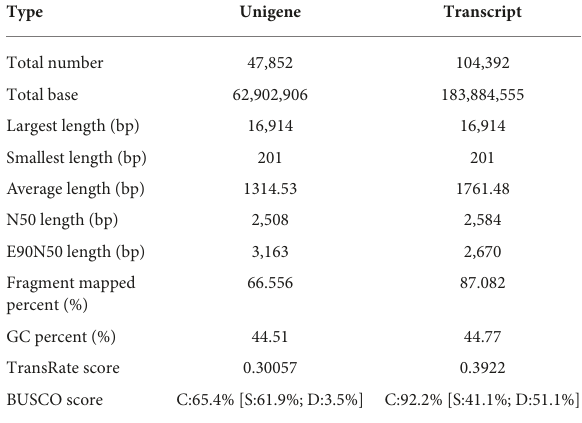
TABLE 2 Evaluation of the assembly